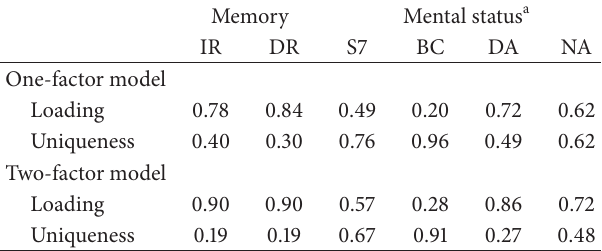
Table 4: Standardized loadings from confirmatory factor analyses.